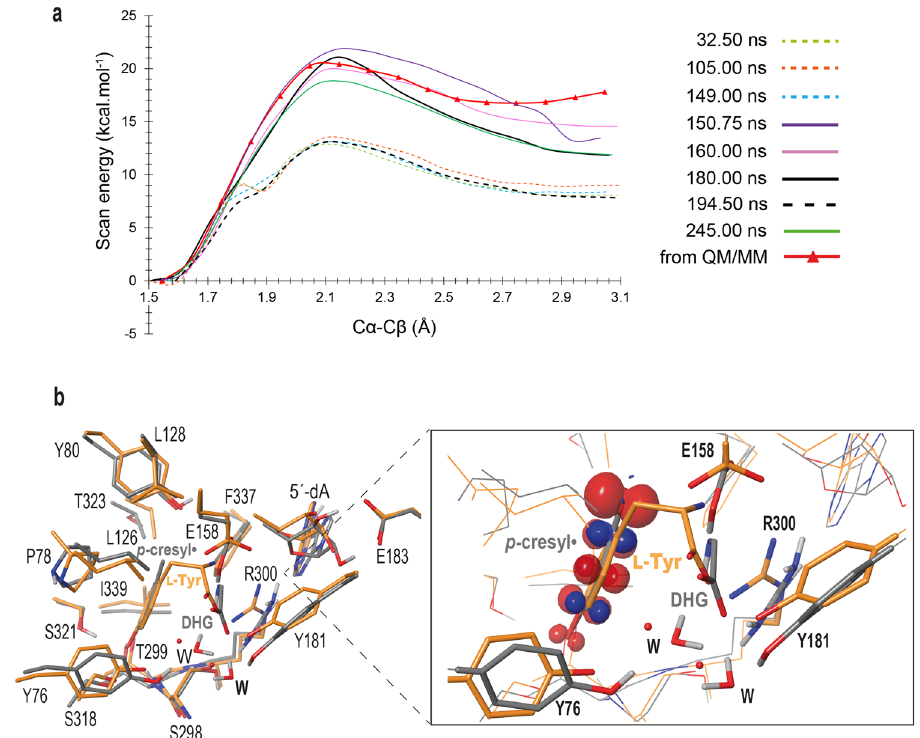
Fig. 6 Release of L-tyrosine cleavage products. a C α – C β distance scan in quantum models restricted to about 300 atoms extracted along the trajectory of the 250-ns MD simulation of L-Tyr bound Tc ThiH (see Supplementary Methods); the corresponding simulation time is given for each curve from 32.5 to 245 ns. The scan depicted as a red line with red triangles was calculated on the same 300 atoms but extracted from the QM/MM product model we obtained (Fig. 4a). b The crystal structure of Tc ThiH active site (C, N, O, H in orange, blue, red and light gray, respectively) is superimposed to the structure corresponding to the geometry optimization of the last point of the scan of the 180-ns products (C, N, O, H in gray, blue, red and light gray, respectively). In the zoom of the L-Tyr (and products) binding site, the spin density is shown for the 180-ns product